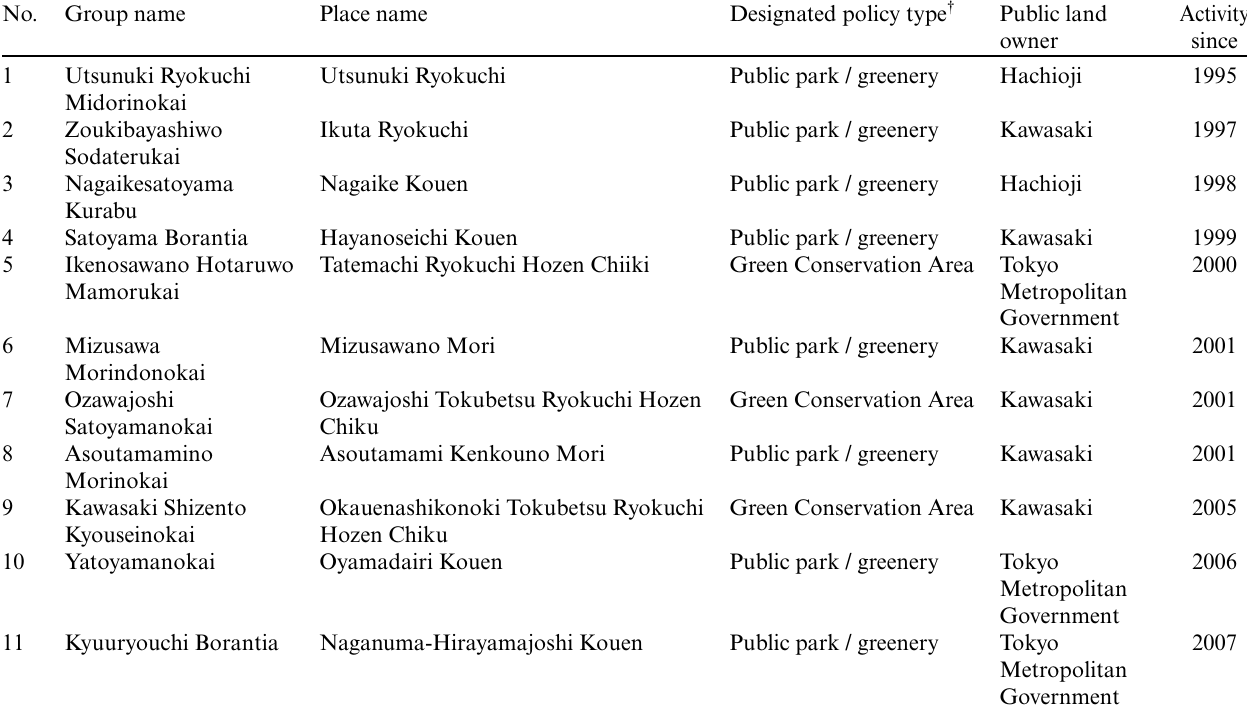
Table 1 . Name, place, and year of establishment of surveyed community groups.